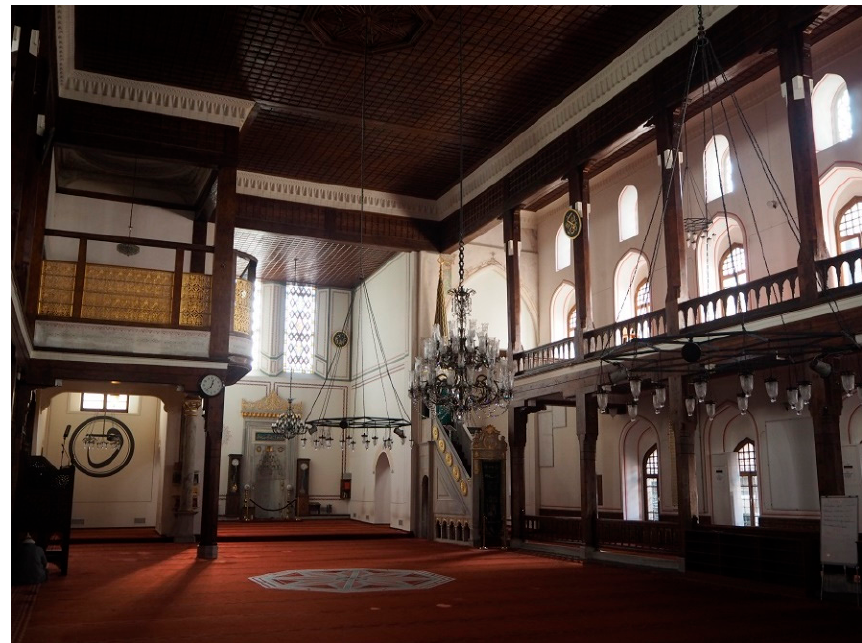
Figure 2. Pera, the church of St. Paul (first quarter of the 14th century), interior towards east, fot. R. Quirini-Pop ł awski (2019).